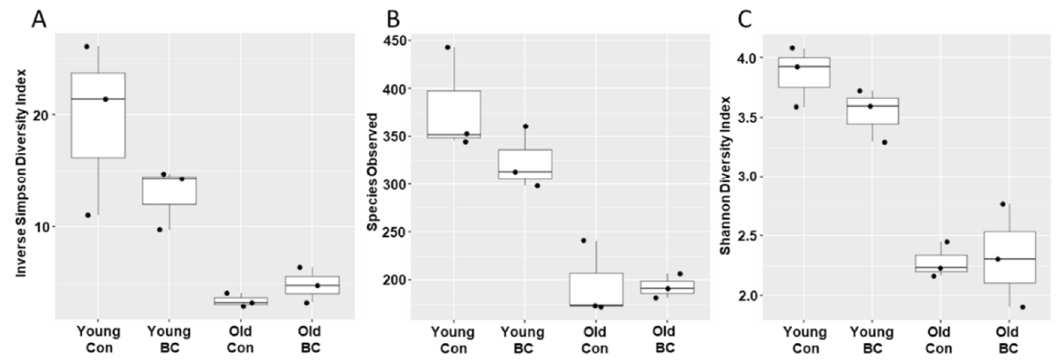
Figure 1. Alpha diversity of microbial samples based on age and diet. ( A ) Species observed, ( B ) Shannon diversity index, and ( C ) inverted Simpson diversity index. Data are represented as boxplots.